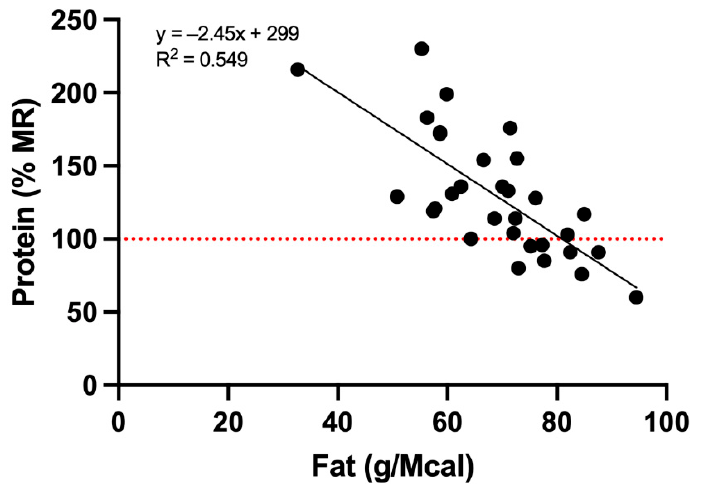
Figure 2. Correlation between fat content (g/Mcal ME) and protein [(percent of FEDIAF minimum requirement) according to species and life stage measured in 31 RMBDs labelled as complete pet